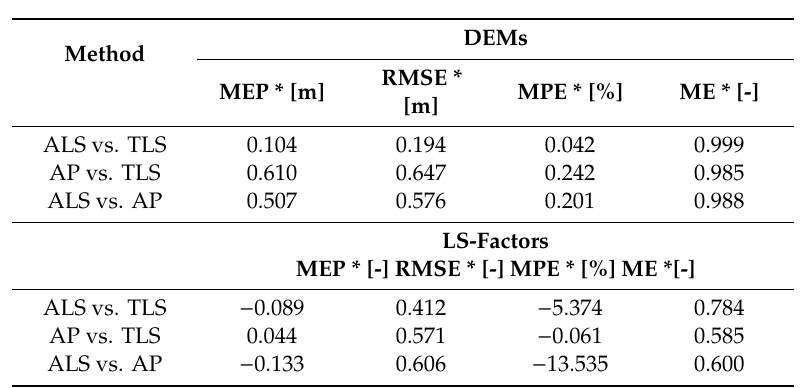
Table 3. MEP, RMSE, MPE, and ME from di ff erent DEMs and LS-factors.